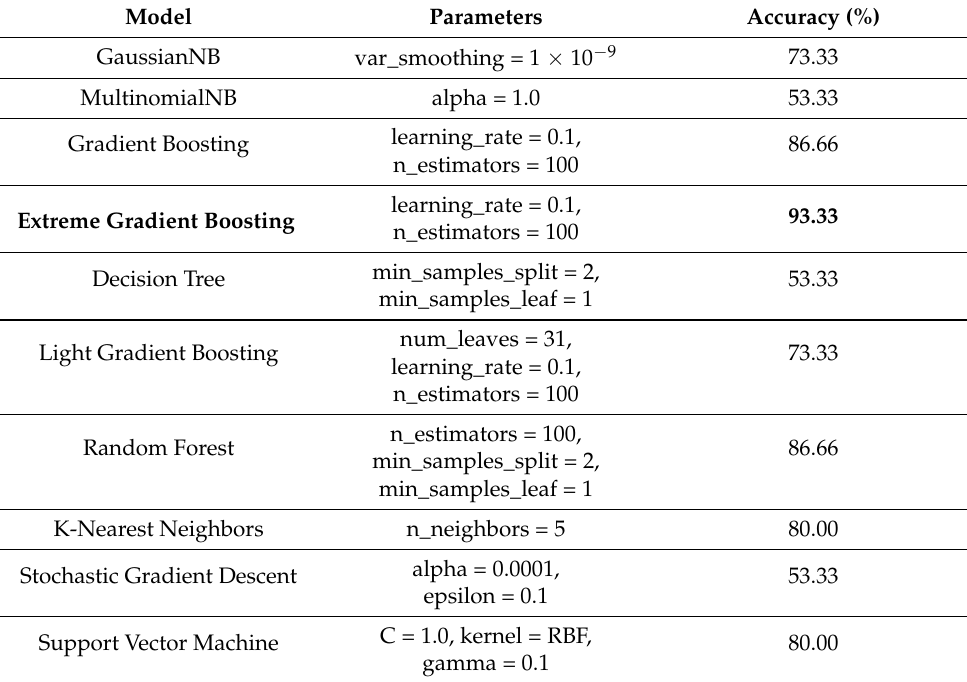
Table 12. Classification report for all